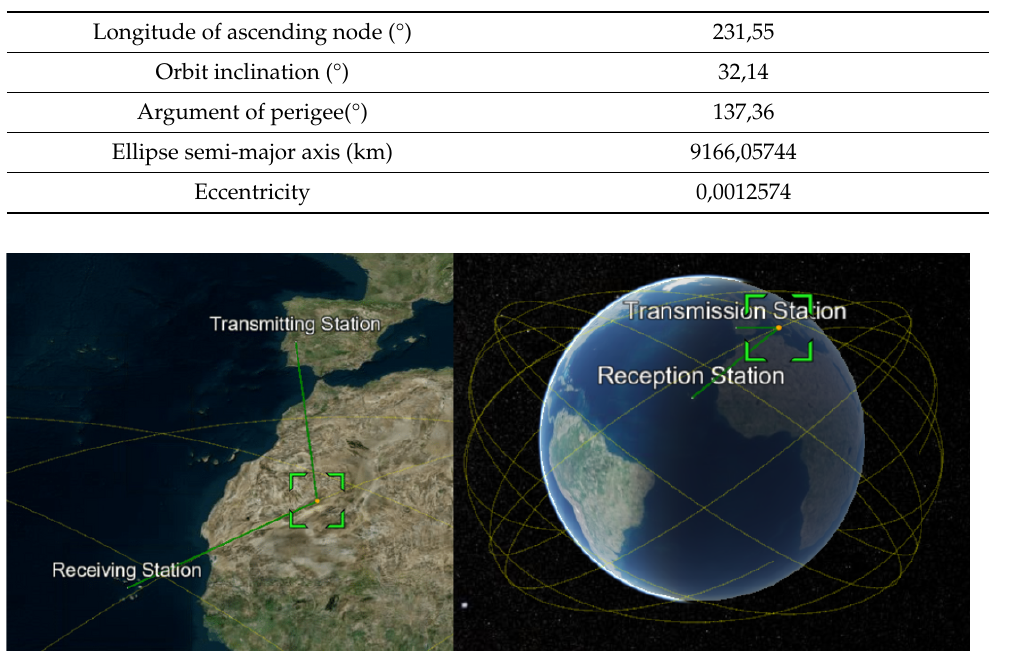
Table 10. Main Keplerian elements of used satellite orbit for the simulated satellite project.